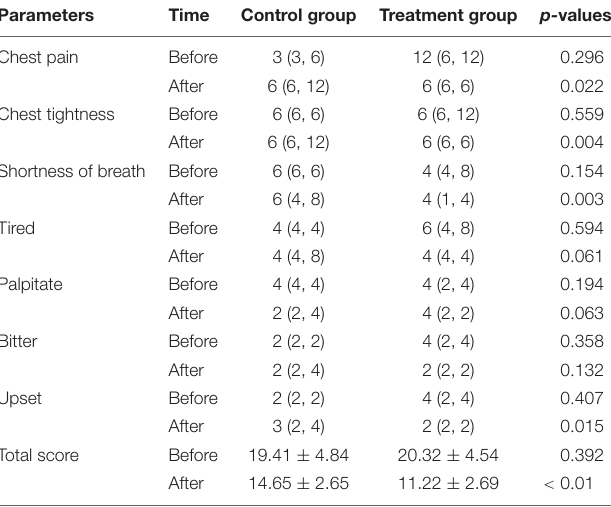
TABLE 9 | The comparison of SAP symptoms between two groups.